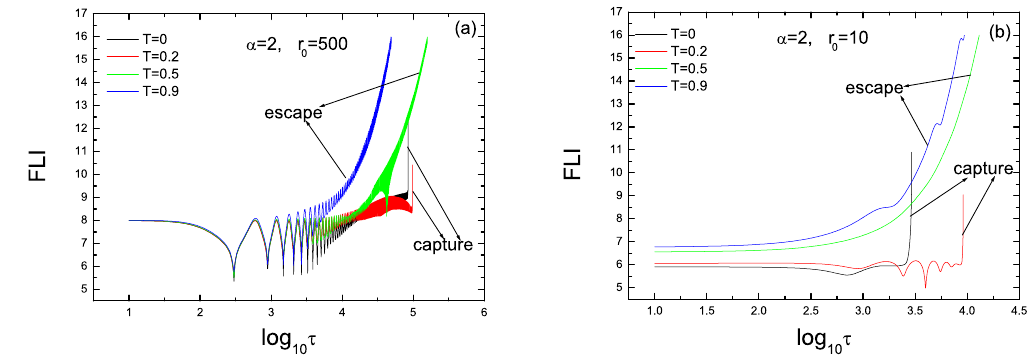
Figure 11 . FLIs with the winding number of closed string (cid:11) = 2 for di(cid:11)erent temperatures T . Left plot is for r 0 = 500 and right plot is for r 0 = 10. Here, we set z = 1. a(cid:11)ect the chaotic dynamics of this system. The properties of chaotic dynamics are sum- marized as what